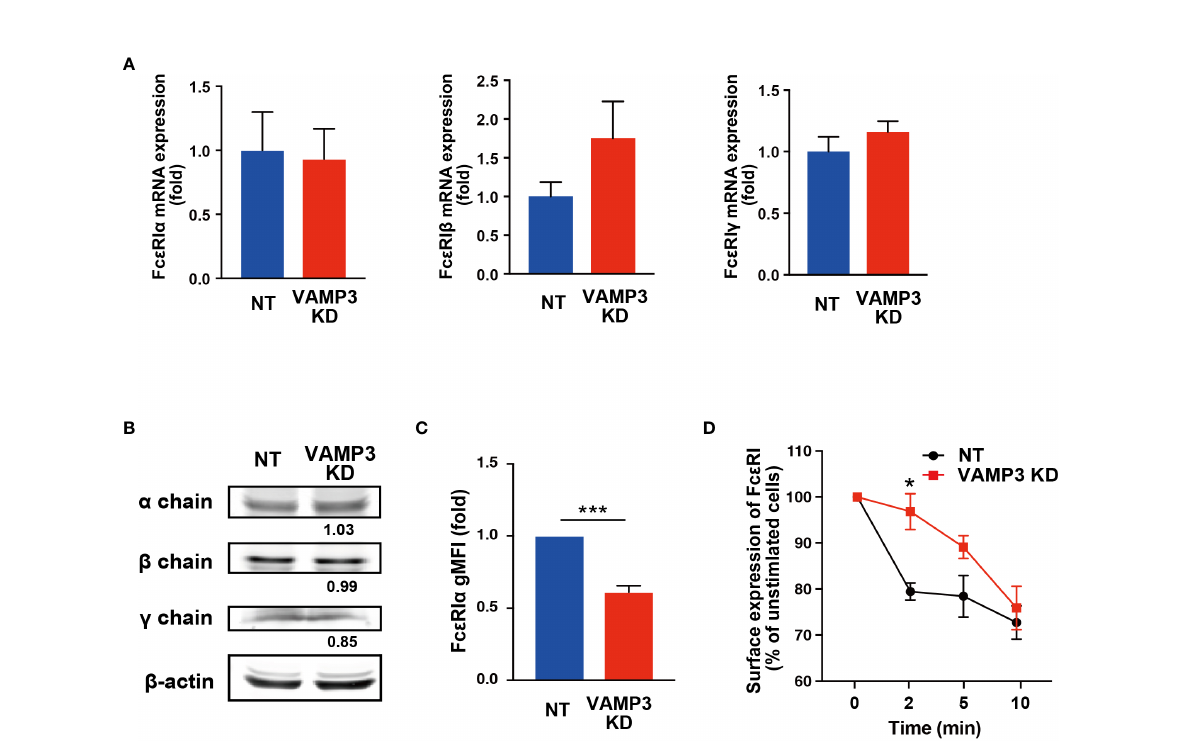
FIGURE 4 No Fc ϵ RI upregulation was observed in cell surface expression or internalization The expression of each subunit of Fc ϵ RI in VAMP3 KD cells was determined. (A) Gene expression was analyzed using quantitative RT-PCR. (B) Protein expression was analyzed using western blot analysis. (C) Cell surface expression levels of Fc ϵ RI a that binds to the IgE Fc region were analyzed using fl ow cytometry in the cells at steady state. (D) Ag- induced time-dependent reduction in cell surface Fc ϵ RI-bound IgE was analyzed using fl ow cytometry. A representative blot is shown for three independent experiments, and the band density normalized to that of unstimulated cells is shown below each band (B) . Data are presented from three independent experiments. Three biological repeats were quanti fi ed in a single run of PCR in the qPCR analysis. NT: control knockdown with a non-targeting shRNA plasmid. Ag: antigen. gMFI: geometric mean fl uorescence intensity. *p<0.05, ***p<0.001; ns, not signi fi